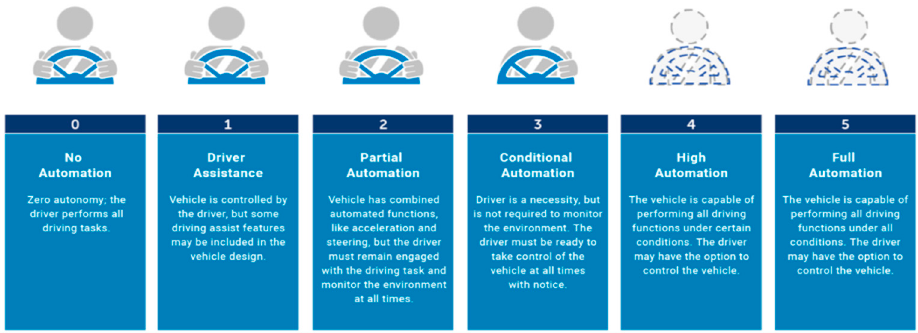
Figure 1. Levels of vehicle automation by NHTSA [15,16].